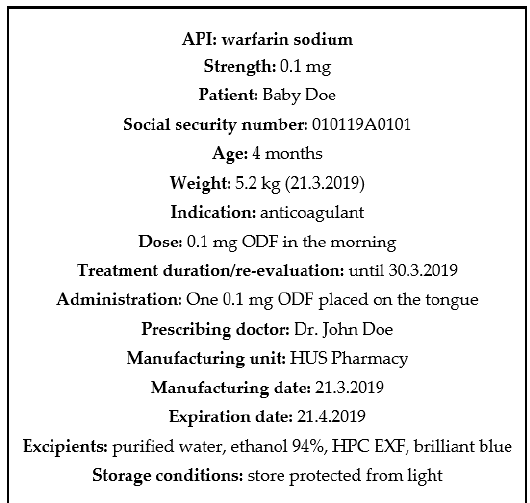
Figure 2. Example of the information that could be included in the QR code.